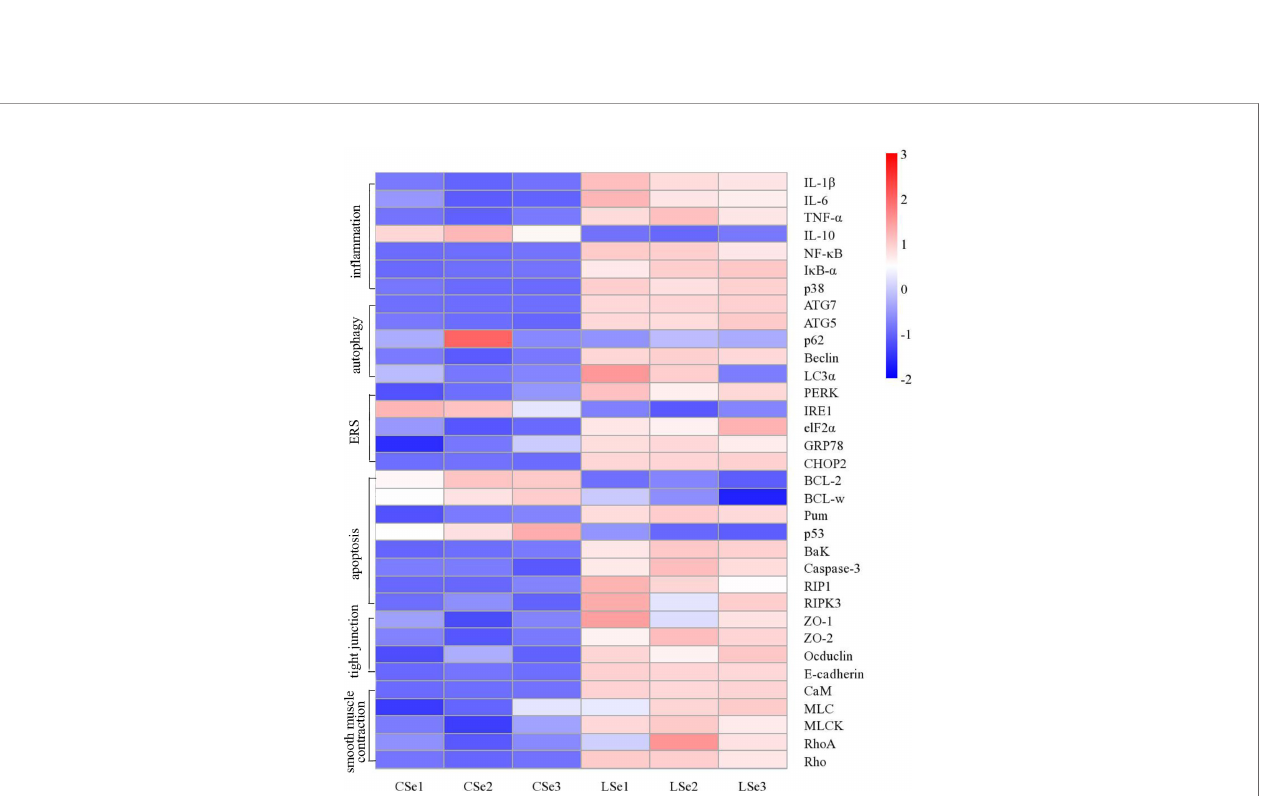
FIGURE 9 | Se de fi ciency caused apoptosis and injury of small intestine in mice. (A, B) Histopathology of small intestine. (A) CSe group; (a) An enlarged image of CSe Group; (B) LSe group; (b) An enlarged image of LSe group; (C, D) TUNEL analysis of small intestinal tissue; (C) CSe group; (D) LSe group.